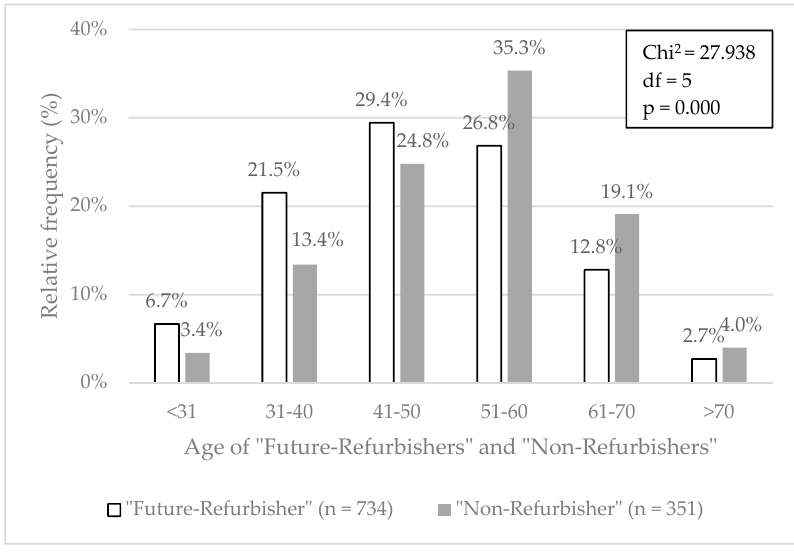
Figure 1. Age groups of “Future-Refurbishers” and “Non-Refurbishers”.